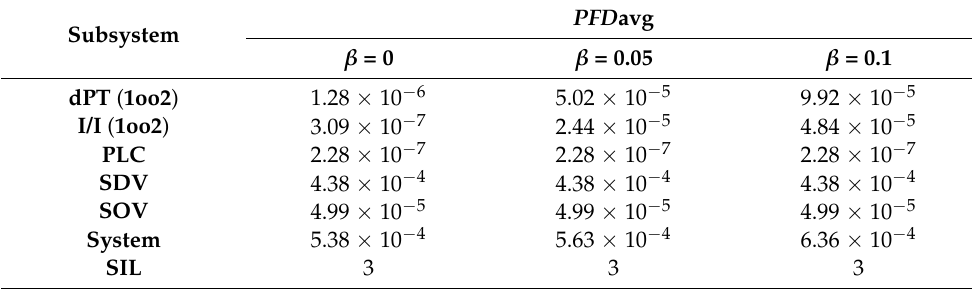
Table 9. Results for different β factor for redundant E/E/PE system.